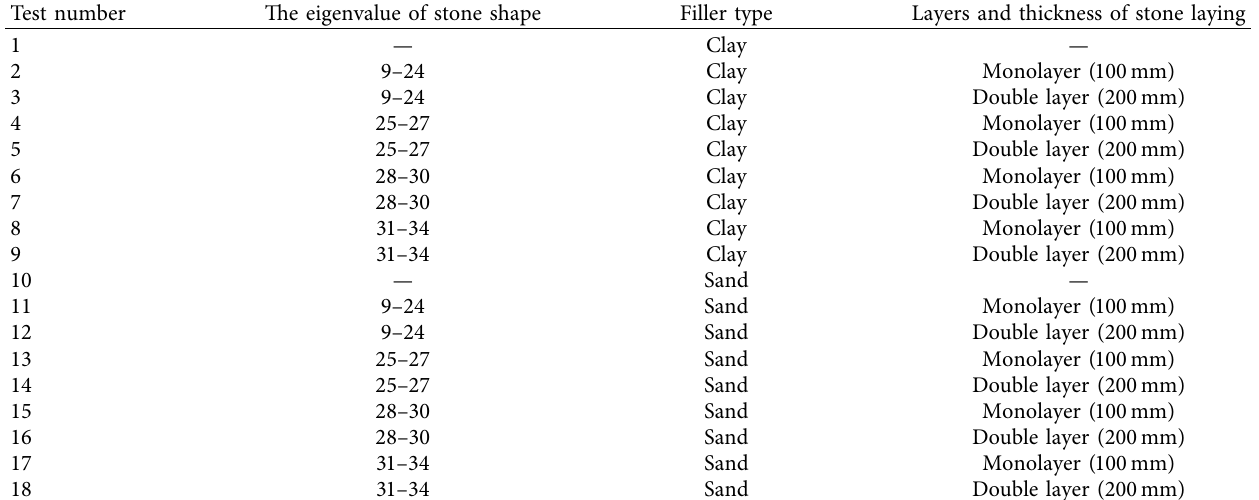
Table 3: Pull-out test